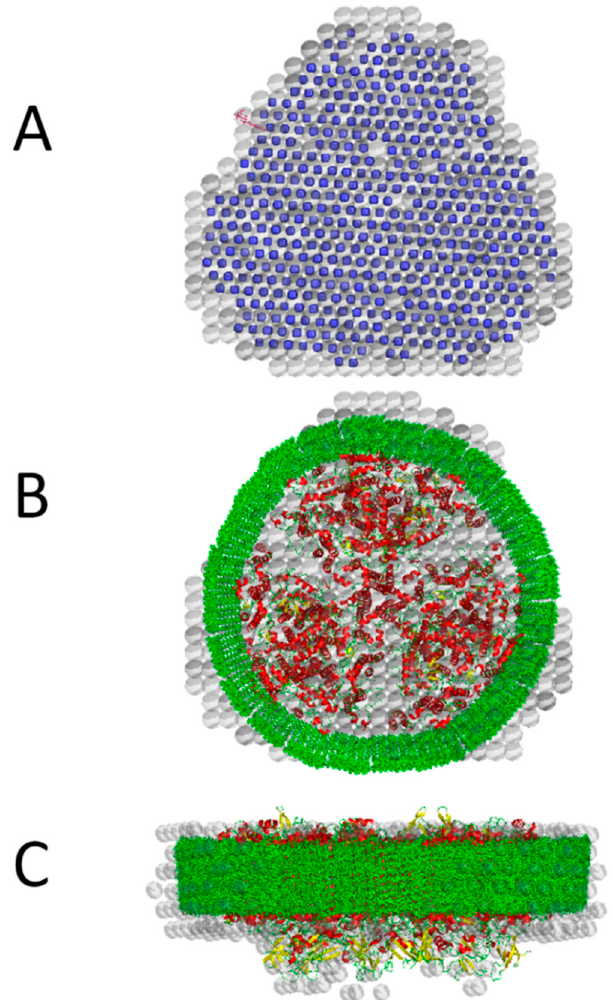
Figure 6. Panel ( A ): Comparison of the ab initio reconstructions of the solution structures of PSI from SANS data with detergent match at 5% D 2 O taken from Figure 3 (blue dots) and of the PSI–detergent complex from SANS data without detergent match at 100% D 2 O (grey spheres, for easy of inspection spheres are shown with 80% transparency). Panels ( B , C ) Top view ( B ) and lateral view ( C ) of the crystal structure of PSI (pdb code 1jb0 [10]) and the solution structure (grey spheres) produced by Dammif based on the SANS data of the PSI–detergent complex at a contrast of 100% D 2 O. The difference can be accounted for by a monolayer of detergent molecules (see green structures).